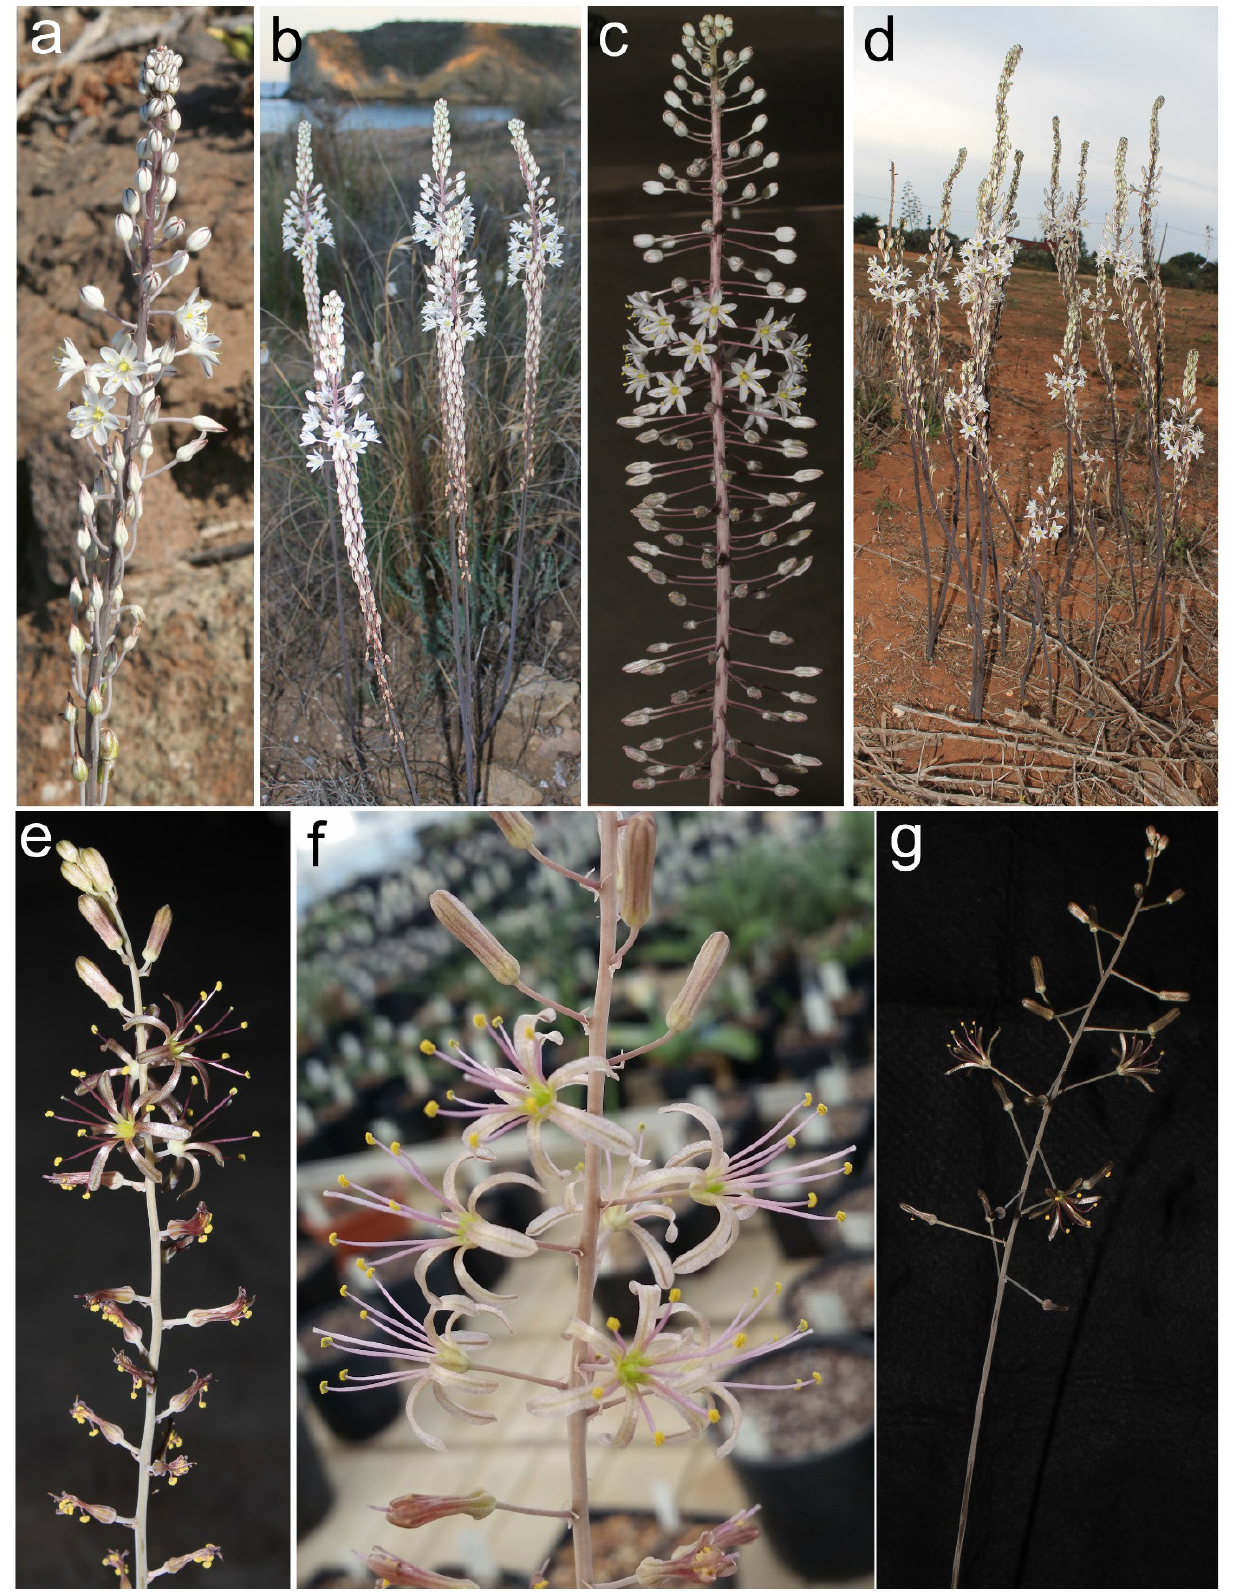
Figure 1. Inflorescences of some Squilla species. A, S. hesperia ; B, S. maritima ; C, S. pancration ; D, S. secundiflora ; E, S. undulata ; F, S. serotina ; G, S. palaestina . 5. Squilla maritima (L.) Steinh. in Ann. Sci. Nat., Bot. sér. 2, 6: 279 (1836) ≡ Scilla maritima L., Sp. Pl.: 308 (1753), basionym ≡ Ornithogalum maritimum